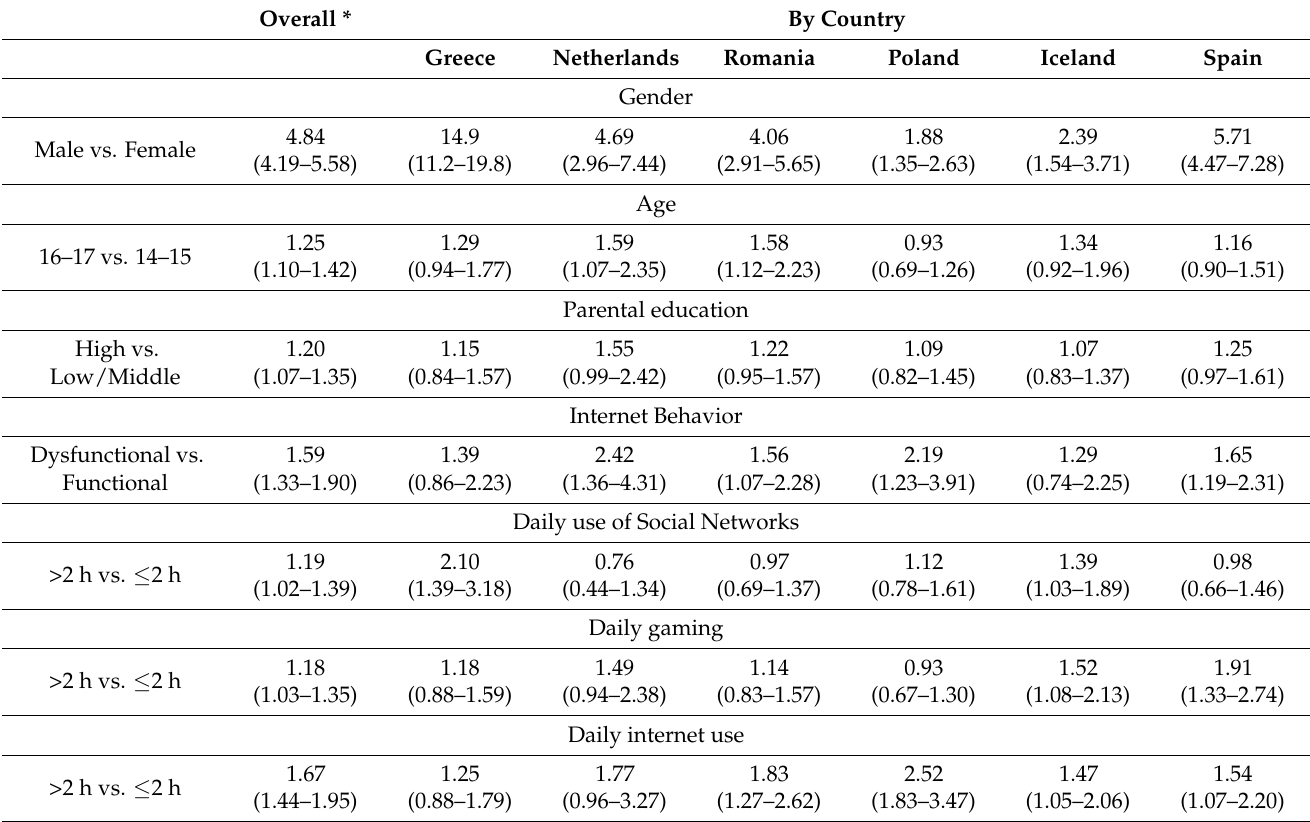
Table 2. Results of logistic regression analyses for any use of pornography in the last 12 months. Table shows odds ratios (adjusted for the other explanatory variables included in the analysis) with 95% confidence intervals. Overall * By Country Gender Male vs.